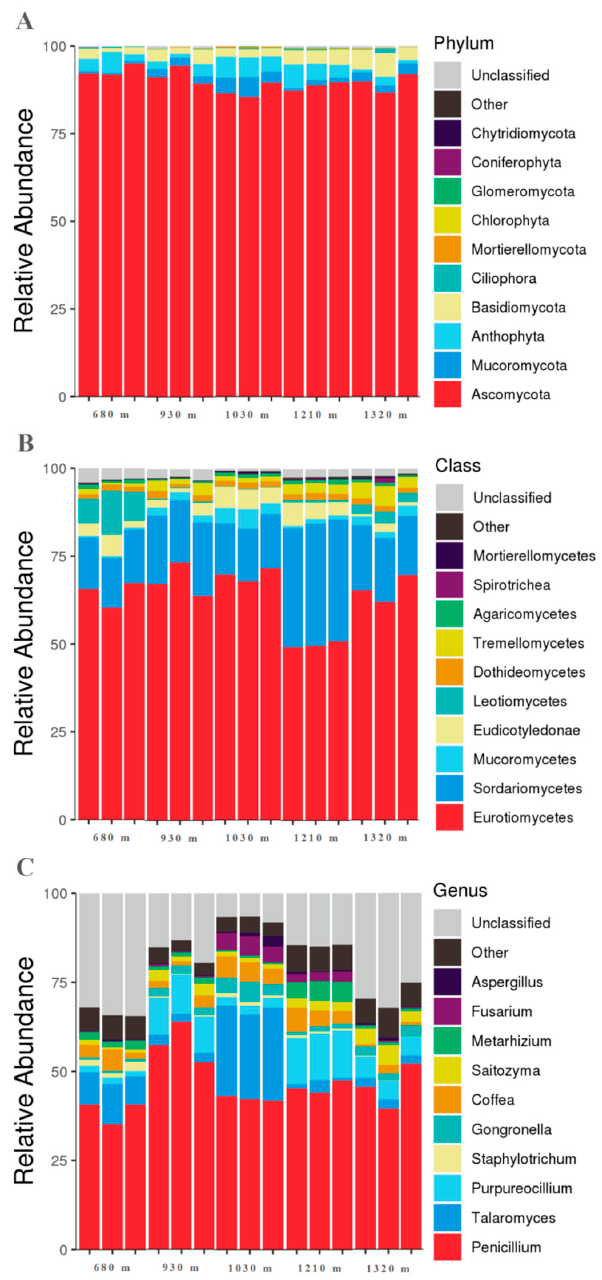
Figure 4. Fungal community composition and structure in the C. arabica rhizospheric soil samples at different altitudes. ( A ) Top 10 fungal phyla. ( B ) Top 10 fungal classes. ( C ) Top 10 fungal genera. Relative abundance was calculated as the percentage of the total effective fungal sequences in a sample. Classifications were based on the SILVA database. Phyla, classes, and genera that were not included in the top 10 in both libraries were classified as ‘Other’. Data are presented for the rhizospheric soil samples collected at altitudes of 680, 930, 1030, 1210, and 1320 m. The dominant fungal classes were Eurotiomycetes (63.63%) and Sordariomycetes (20.23%) (Figure 4B). The relative abundance of Eurotiomycetes initially increased, peaking at 1030 m, but then decreased at 1210 m and increased slightly at 1320 m. As the